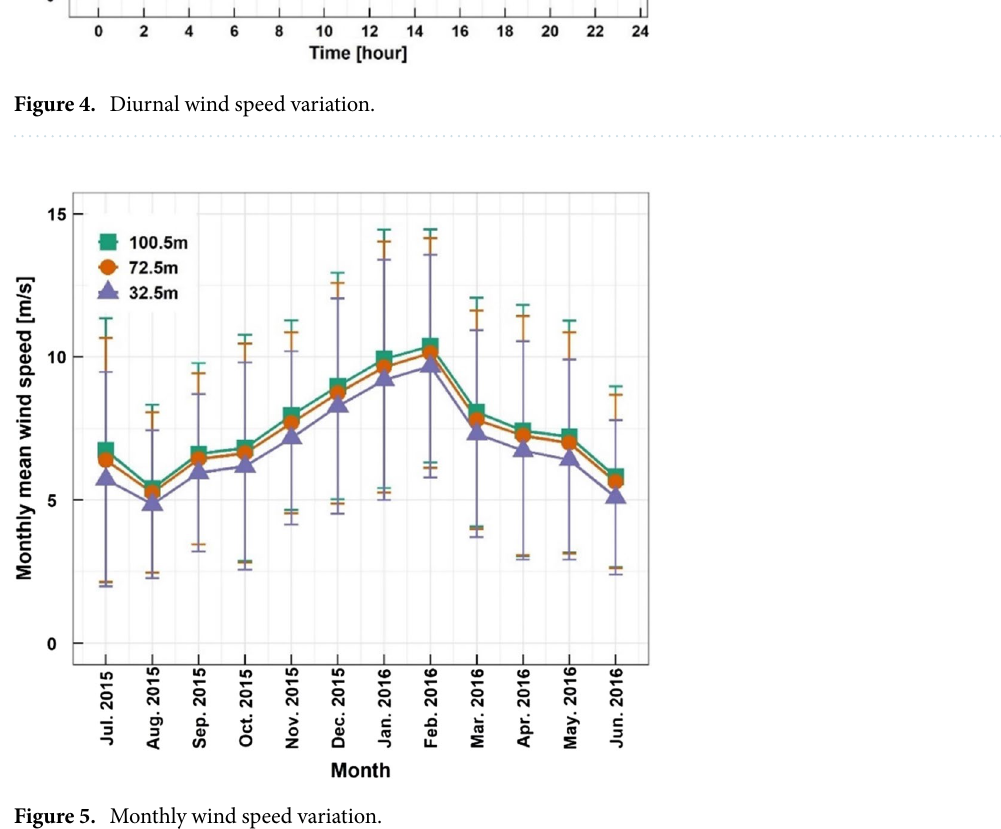
Figure 5. Monthly wind speed